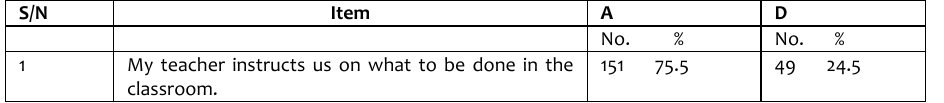
Figure 1: Percentage Presentation of data for question